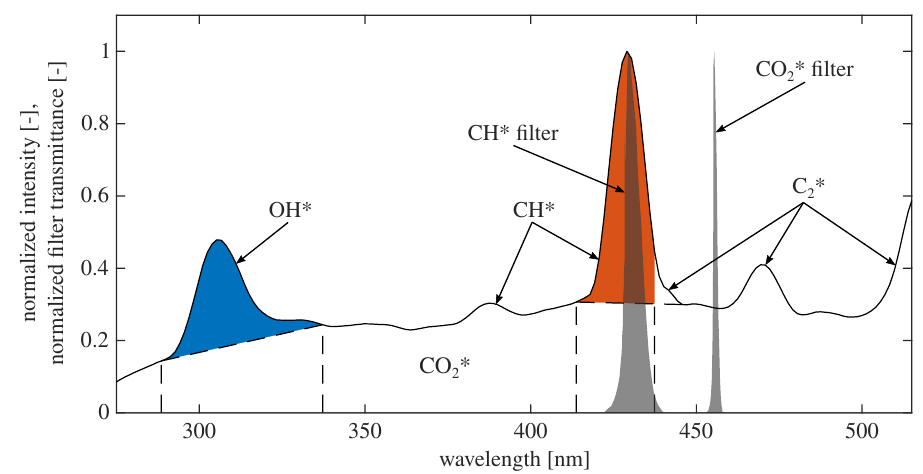
Figure 2. Typical chemiluminescence spectrum of a lean kerosene flame under atmospheric